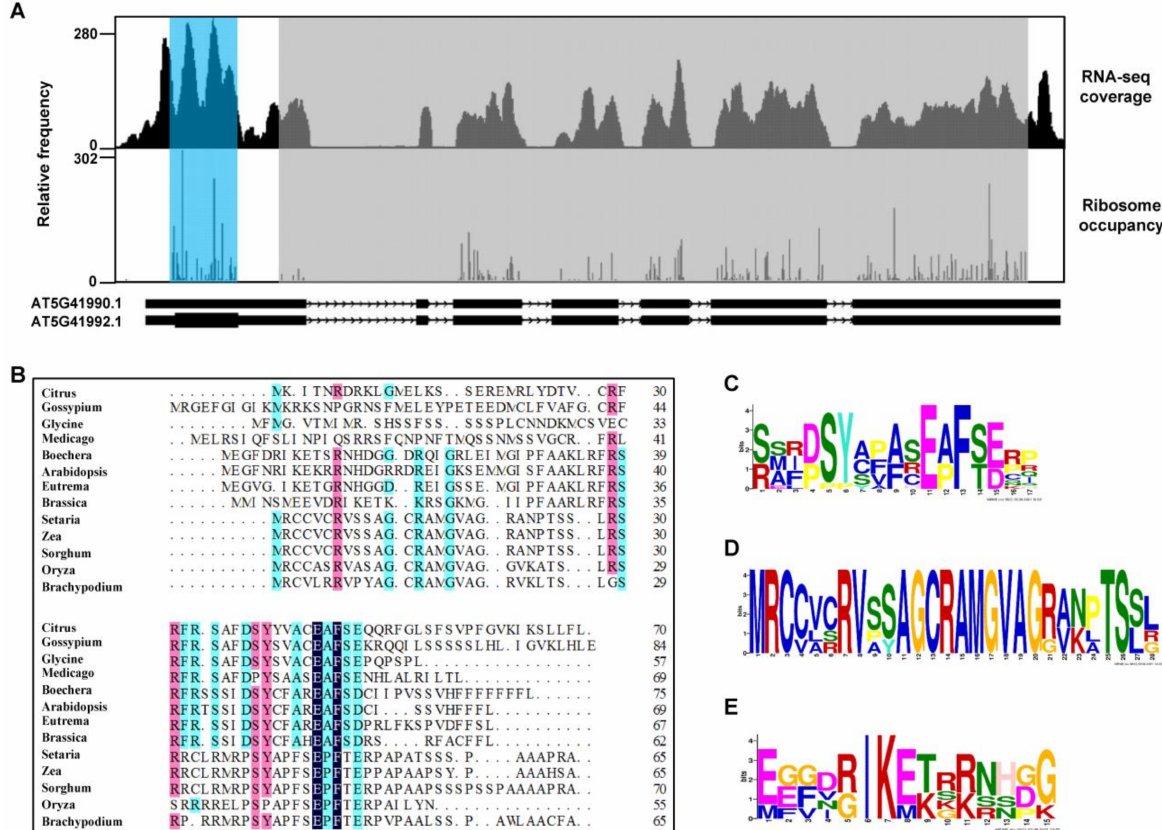
Figure 2. Conserved open reading frame is found in the 5 (cid:48) -UTR of WNK8. ( A ) Comparative ribosome footprinting profile of WNK8 . The coverage of RNA-seq reads is shown in upper panel and the ribosome occupancy is shown in lower panel. Light blue: CPuORF58; Gray: main ORF; White: UTR. ( B ) Sequence alignment of the predicted amino acid sequences of CPuORF58 from different plant species. The sequence logos are resulted from the sequence alignment of the uORFs from all selected plant species ( C ), monocts ( D ), and dicots ( E ). Letter height indicates the frequency in the